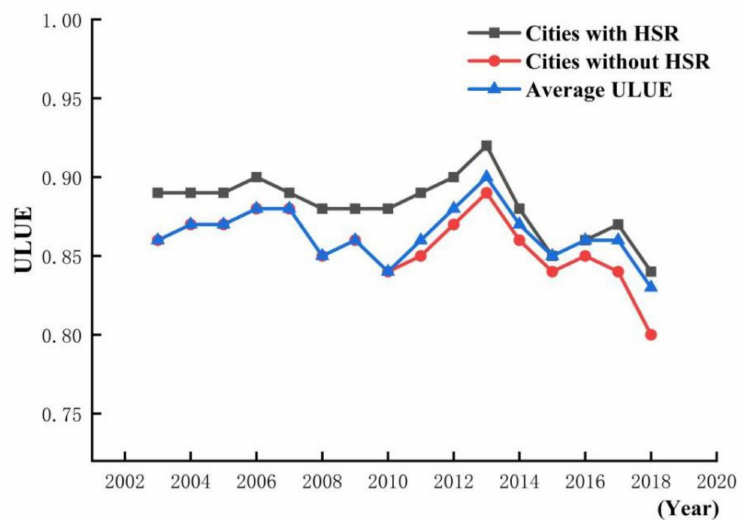
Figure 2. The changes in ULUE of the cities with HSR and without